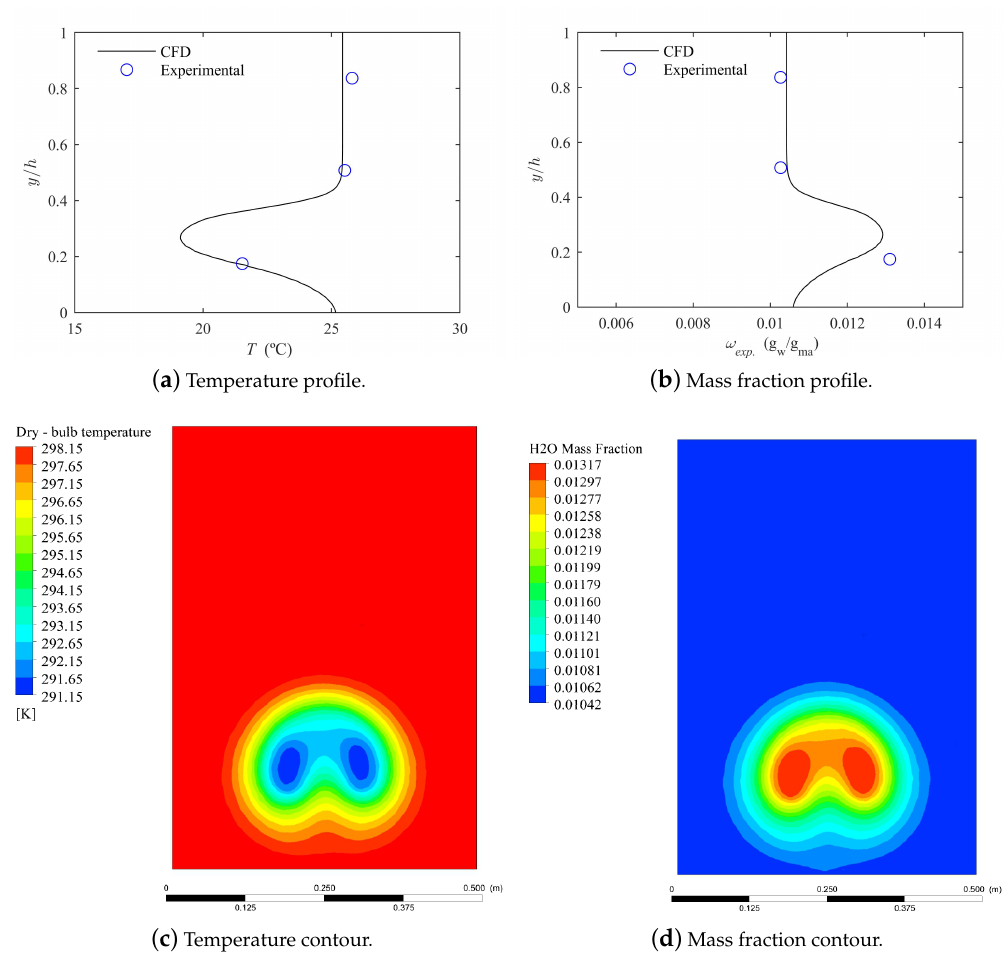
Figure 7. Comparison between predicted and experimental results (temperature and water mass fraction) evaluated at the measuring section for the first test presented in Table 2.